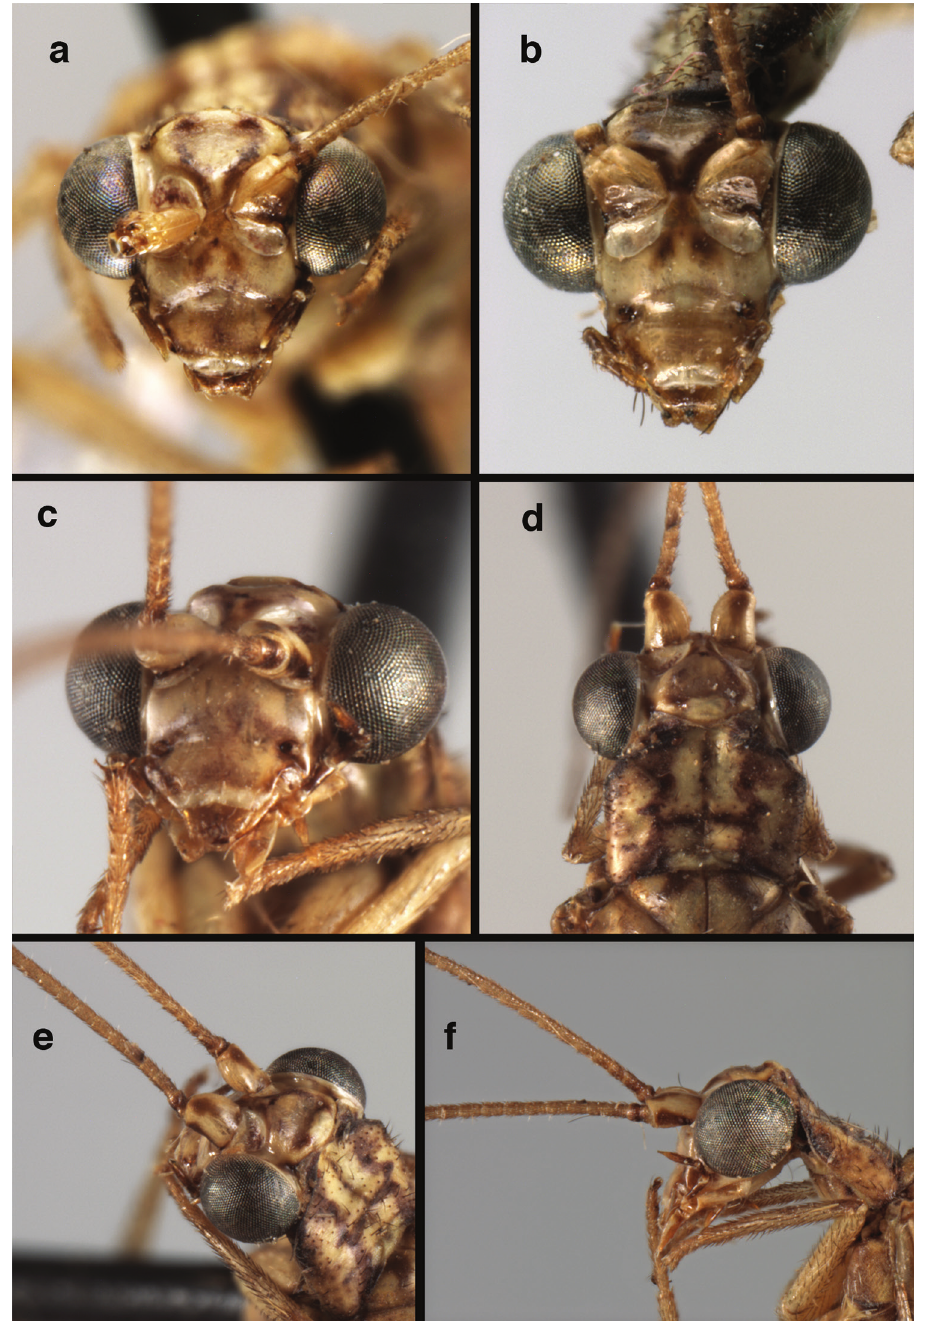
Figure 103. Ungla argentina (Navás): External features, ( a, b, c ) head, frontal [Note variation in frontal markings.] ( d ) head, prothorax, dorsal ( e ) head, prothorax, dorsolateral ( f ) head, prothorax, lateral (Ar- gentina, Santiago del Estero, CAS; a male; b–f